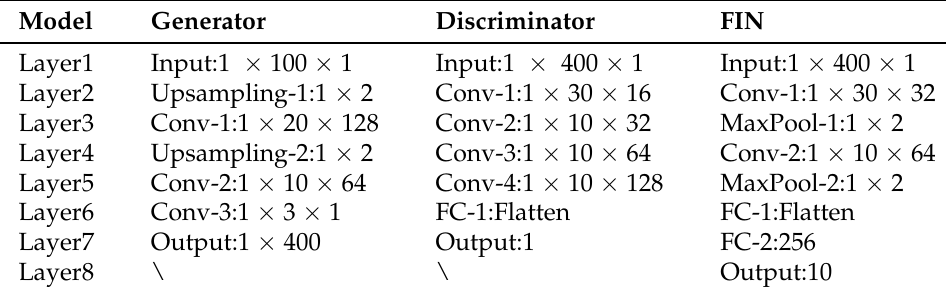
Table 1. Detailed structure parameters of the